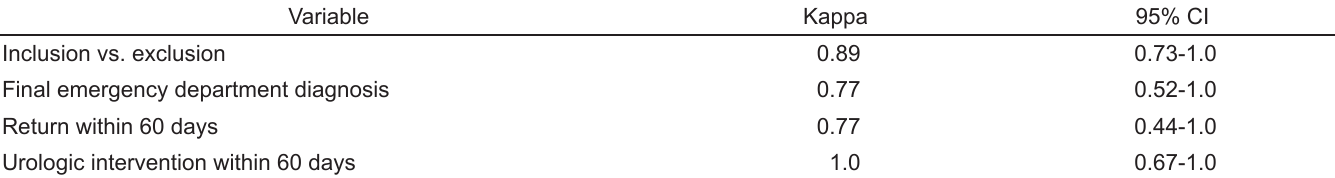
Table 4. Kappa values calculated for 10% of